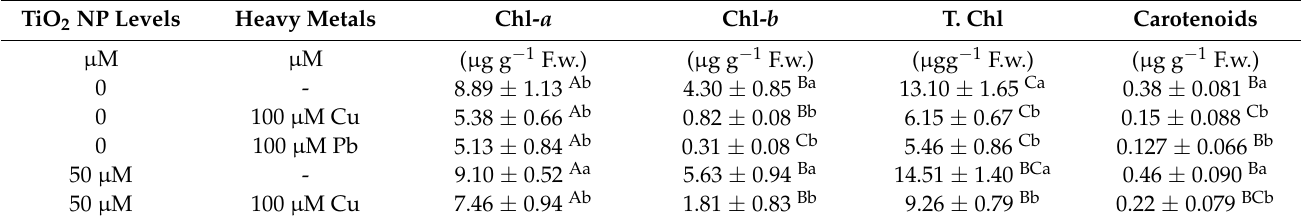
Figure 2. The impacts of TiO 2 NP levels on H 2 O 2 ( a ), MDA ( b ), and SP ( c ) contents in A. pygmaea with 100 µ M Cu and 100 µ M Pb. The treatments contained various levels of TiO 2 NPs alone or in combination with 100 µ M Cu and 100 µ M Pb. The capital letters show statistically significant differences across various levels of TiO 2 NPs alone or in combination with 100 µ M Cu and 100 µ M Pb (the bars with the same colors), while the lowercase letters show statistically significant differences within each level of TiO 2 NPs alone and in combination with 100 µ M Cu and 100 µ M Pb (the bars with different colors) according to Tukey (cid:48) s test ( p < 0.05). Table 2. The impact of the combination of TiO 2 NPs with 100 µ M Cu and 100 µ M Pb on the contents of chlorophyll- a , chlorophyll- b , total chlorophyll, and carotenoids. Each data point is the mean ± SE of five replicates. The treatments included four concentrations of TiO 2 NPs (50, 80, 100, 150 µ M) alone and in combination with 100 µ M Cu and 100 µ M Pb. The capital letters show statistically significant differences across different concentrations of TiO 2 NPs alone or in combination with 100 µ M Cu and 100 µ M Pb, while the lowercase letters show statistically significant differences within each concentration of TiO 2 NPs alone and in combination with 100 µ M Cu and 100 µ M Pb, according to Tukey (cid:48) s test ( p < 0.05). They are subscribed on top of the